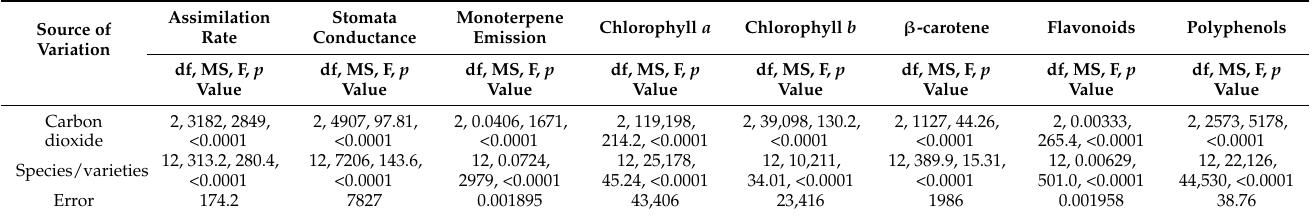
Table 2. The hierarchical model of ANOVA analysis between treatment (different carbon dioxide concentrations) and